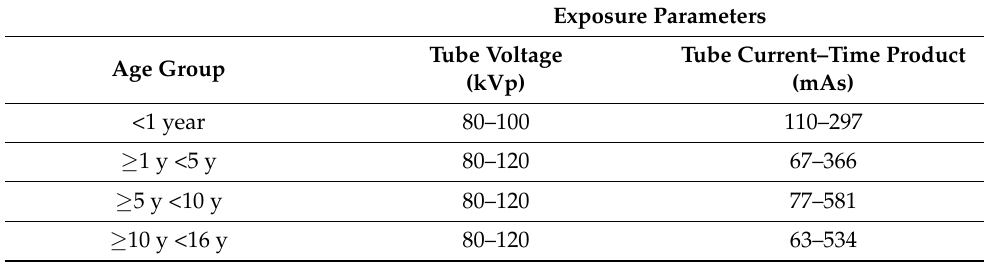
Table 1. Exposure parameters (tube voltage and tube current–time product) for the age groups considered in this study.